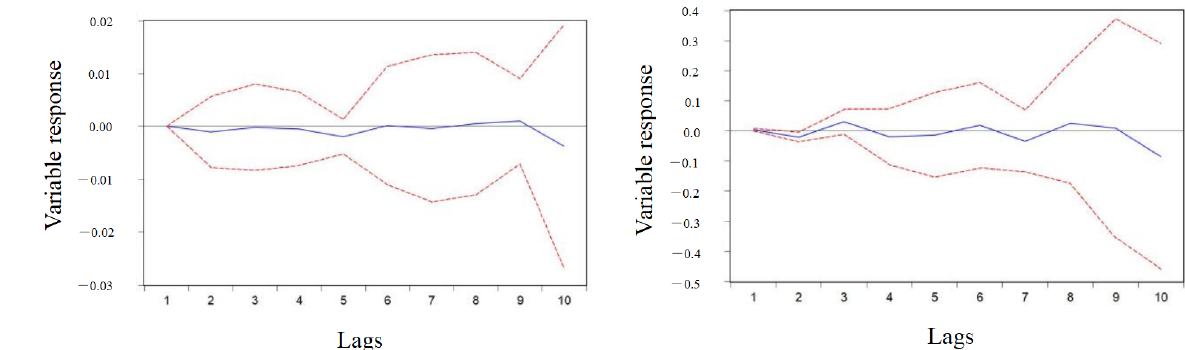
Figure 8. Impulse response function of carbon effects and agricultural multifunctionality.